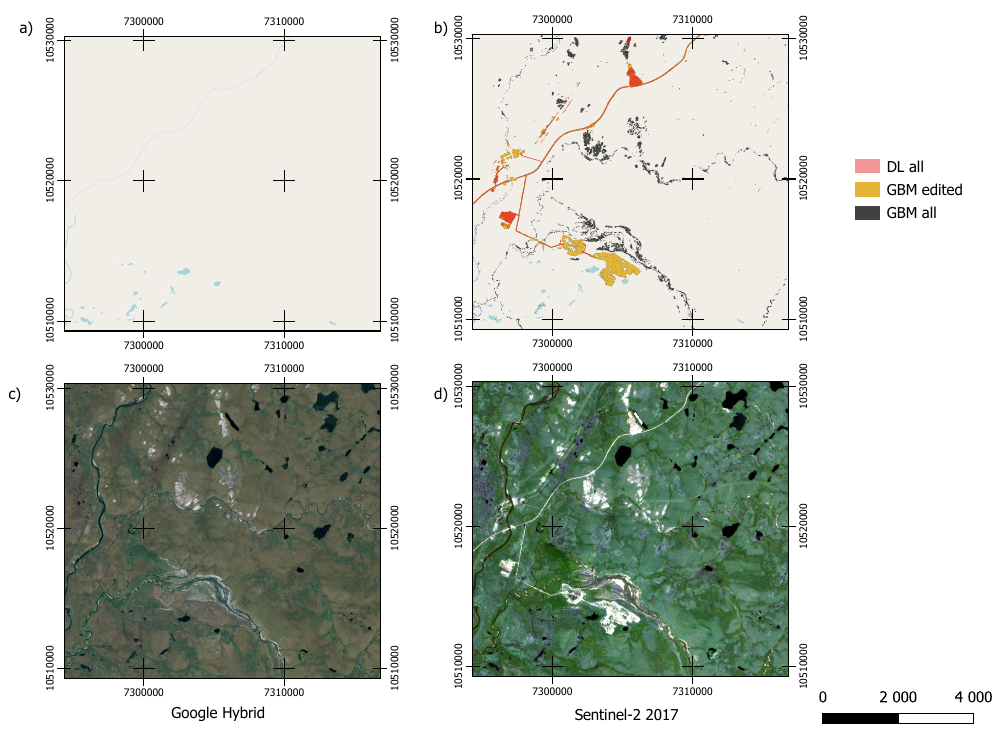
Figure 14. Example of classification results of human-impacted areas in comparison to OpenStreetMap and the Google online hybrid map within Sentinel-2 granule 41WPR (Western Siberia, see Figure 3): ( a ) OpenStreetMap (gray—roads, blue—waterbodies); ( b ) classification results for Deep Learning (DL, Sentinel-2 only; transparency 50%) and Gradient Boosting Machines (GBM, Sentinel-1 (VV) and Sentinel-2; all and manually edited for false classifications), background OpenStreetMap; ( c ) Google online hybrid map; and ( d ) Sentinel-2 red–green–blue (band 4-3-2) composite 15.07.2017. Projection WGS 84/UTM zone